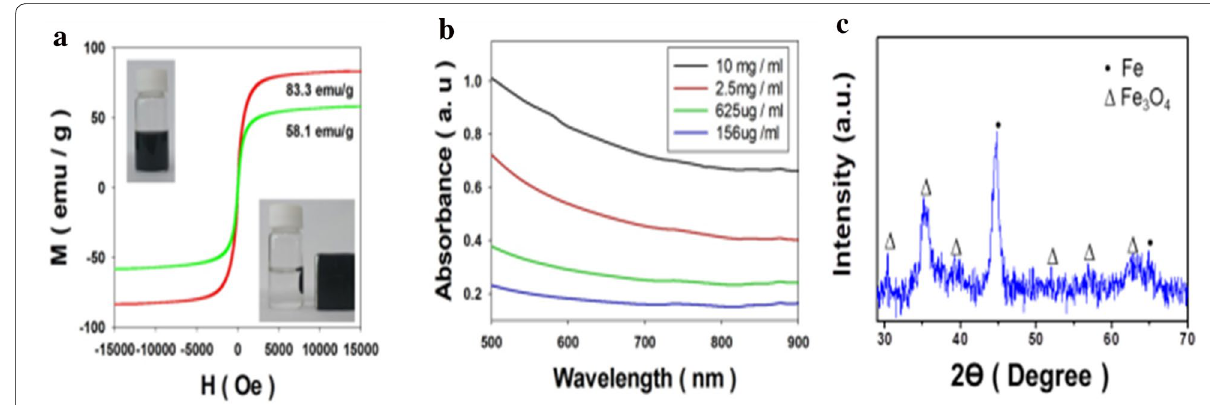
Fig. 2 Hysteresis curve of a the synthesized Fe@Fe 3 O 4 nanoparticles (red) and the particles after coated with DMSA (green), insert shows the nanoparticle dispersion response to the outer permanent magnet. b Plots of the absorbance spectrum according to the concentration of the DMSA coated particle dispersion, and c XRD pattern of the Fe@Fe 3 O 4